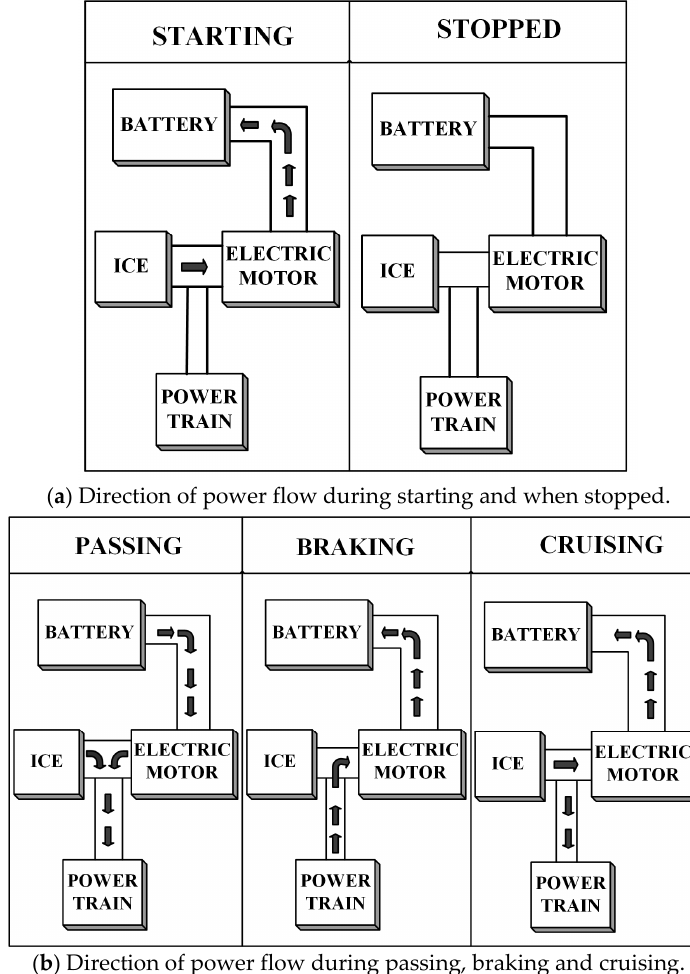
Figure 4. Power flow among the basic building blocks of an HEV during various stages of a drive cycle. Adapted from [8].